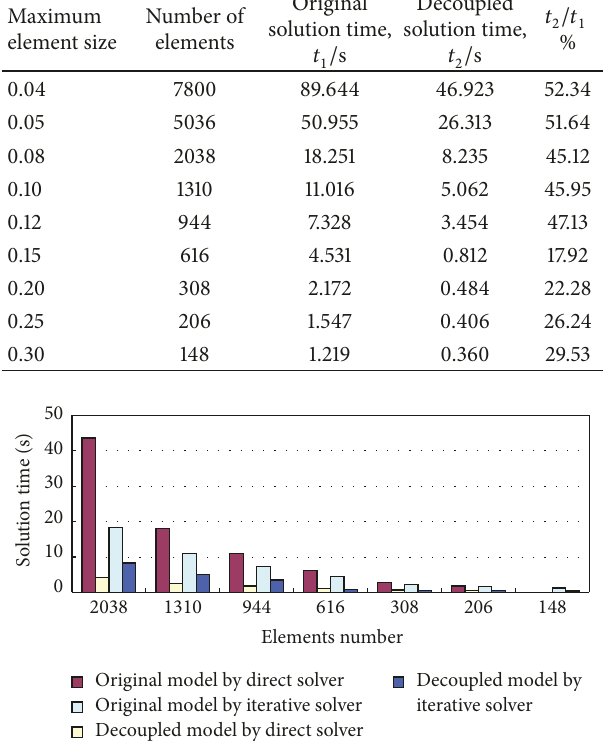
Figure 2: Comparison of solution